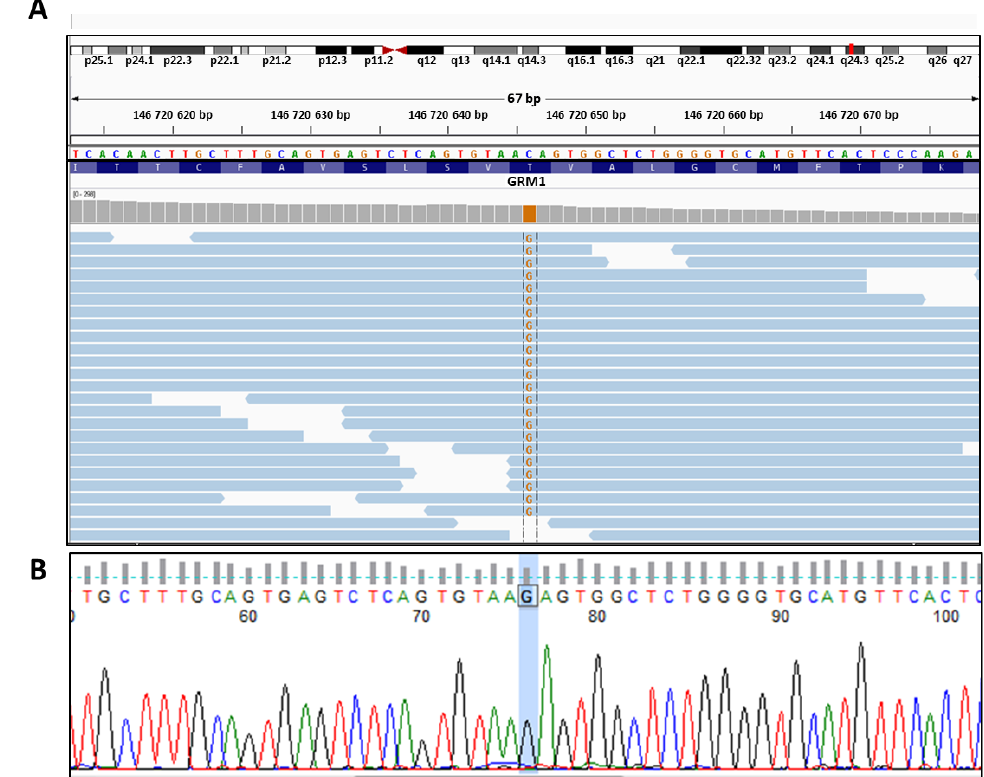
Figure 1. Identification of a novel mutation in the GRM1 gene in a patient AIV-1. ( A ) — Visualization of the genomic region harboring the candidate non-synonymous variant in the GRM1 gene (hg19 chr6:g.146720646 C>G) using the IGV tool [29]. ( B ) — Validation of a candidate homozygous variant in patients (AIV-1).